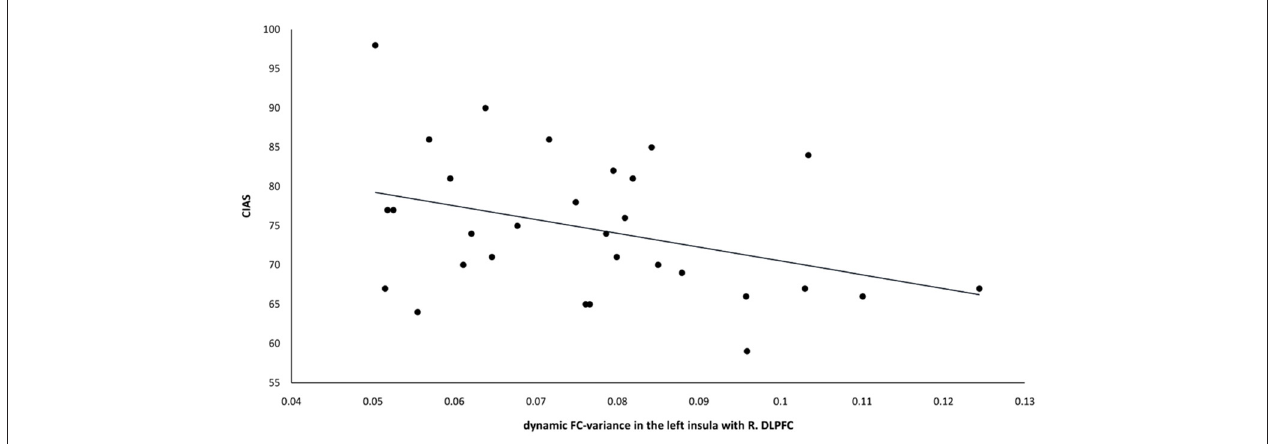
FIGURE 5 | The dynamic FC-variance between the left insula and right DLPFC was negatively correlated with the CIAS scores of the IGD group ( r = − 0.369, p = 0.045). FC, functional connectivity; DLPFC, dorsolateral prefrontal cortex; CIAS, Chen Internet Addiction Scale; IGD, internet gaming